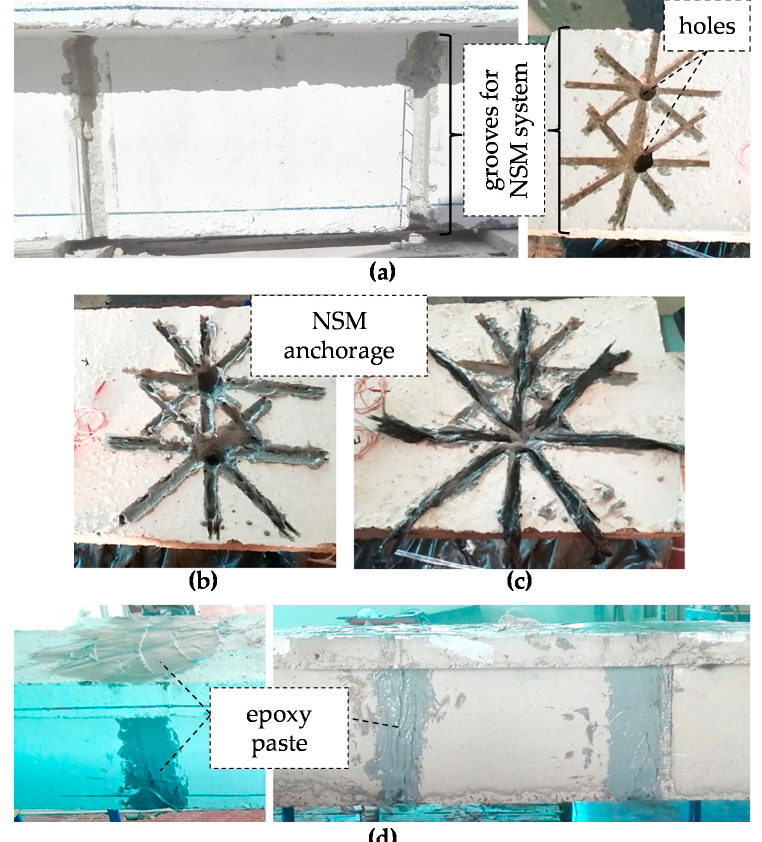
Figure 4. Strengthening application stages of the T-shaped cross-section beam: ( a ) drilling holes through the slab and grooves at the top of the slab, the sides, and the bottom width of the web; ( b ) adhesive epoxy paste injected inside the slab holes and applied in the web grooves and the top slab grooves of the anchorage; ( c ) insertion of the impregnated CFRP ropes inside the slab holes and the web grooves and anchorage of their free length carefully inside the grooves using supplementary epoxy paste; ( d ) sealing and filling of the grooves with extra epoxy adhesive up to the level of the concrete surface.